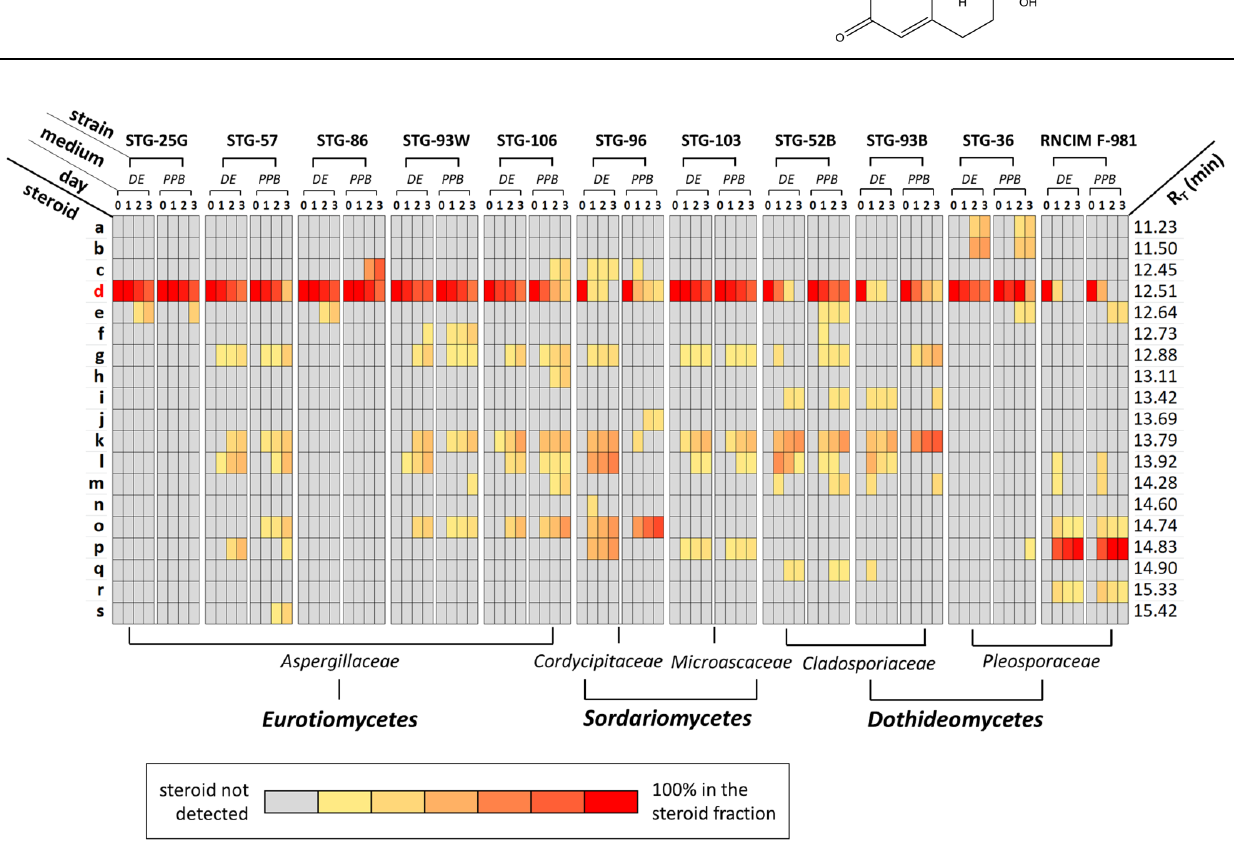
Figure 3. The dynamic of androst-4-ene-3,17-dione ( d ) transformation by filamentous fungi-destructors of tempera painting materials, isolated in the State Tretyakov Gallery, Moscow, Russia (STG-25G, STG-57, STG-86, STG-93W, STG-106, STG-96, STG-103, STG-52B, STG-93B, STG-36), and by the industrial strain Curvularia lunata RNCIM F-981 (control). Data on 0, 1, 2, and 3 days after the addition of 1 g/L substrate ( d ) is based on gas chromatography/mass spectrometry analysis. DE—liquid defined medium, PPB—potassium phosphate buffer. Substrate ( d ) in bold red; all other compounds ( a – c , e – s ) are steroid conversion products and are not colored (black, bold). R T —retention time.